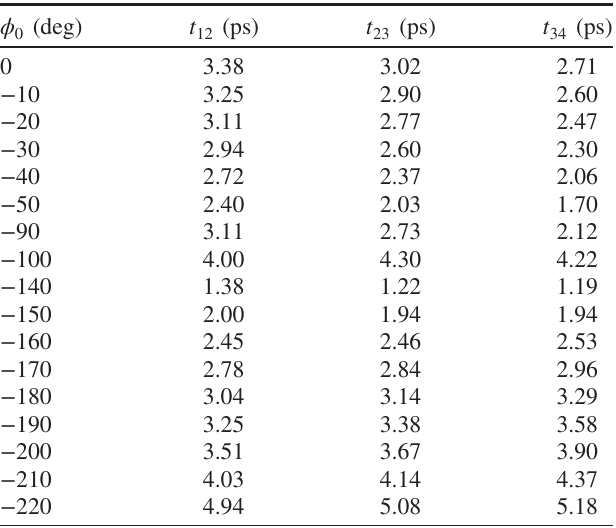
TABLE III. Bunch intervals in a 4 × 20 pC bunch train with different injected phases ϕ 0 .